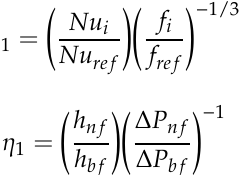
Figure 18. The variations of the thermal ‐ hydraulic performance of different studied channels versus solid concentration in different flow rates: ( a ) 2 lpm, ( b ) 3.5 lpm, and ( c ) 5 lpm. Reproduced with permission from [205]. Elsevier, 2014.